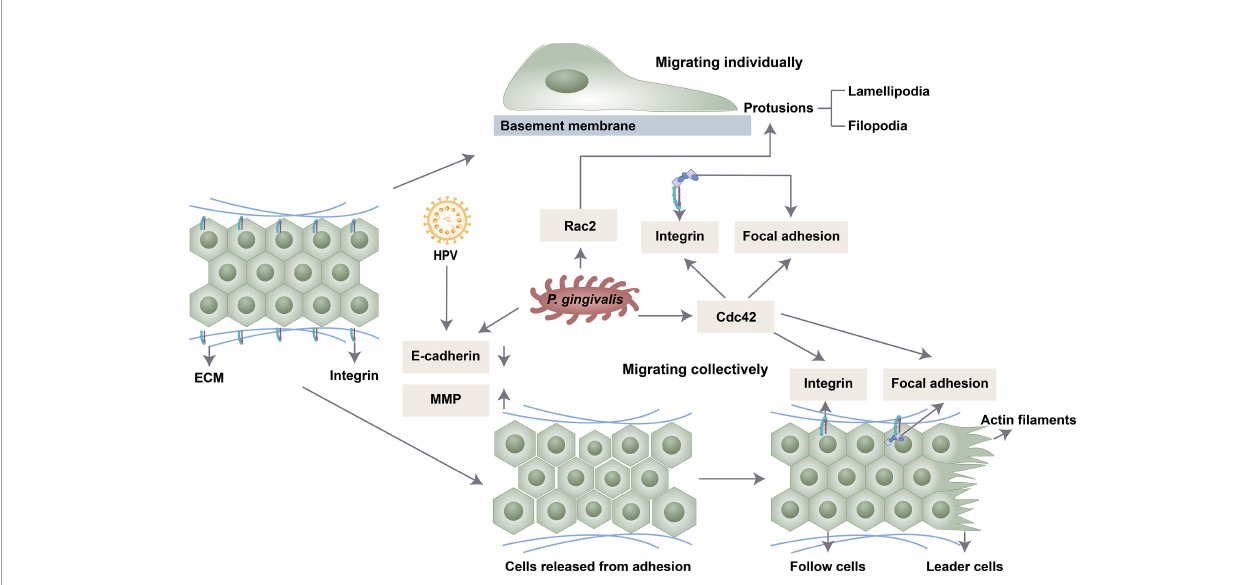
FIGURE 1 | Possible mechanisms by which oral microbiota in fl uence cell migration. P. gingivalis and HPV 16 release intercellular adhesions by downregulating E-cadherin and upregulating MMP. P. gingivalis enhances the expression of Cdc42 and Rac2 to induce the front and back polarity that is crucial for cell migration. P. gingivalis drives cell clusters to move orientally through the formation of integrin and focal